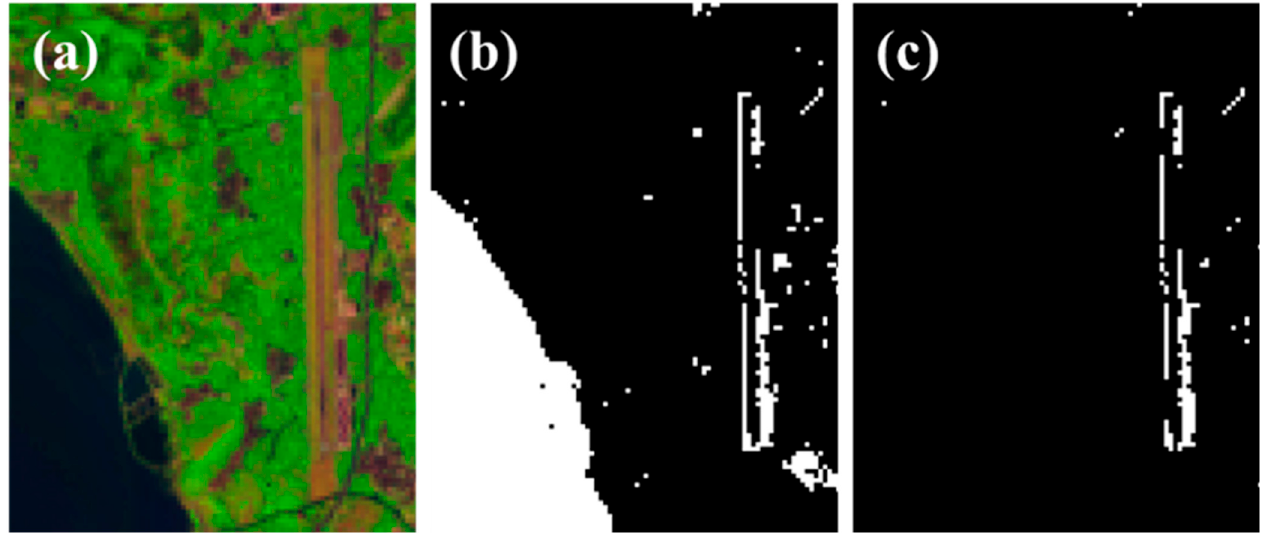
Figure 5. Example of the PIF mask determination. ( a ) False color image (R: SWIR band, G: NIR band, B: Blue band) with vegetation in green; ( b ) Construction land and water; and ( c ) PIF mask over airports near Lake Taihu, China.